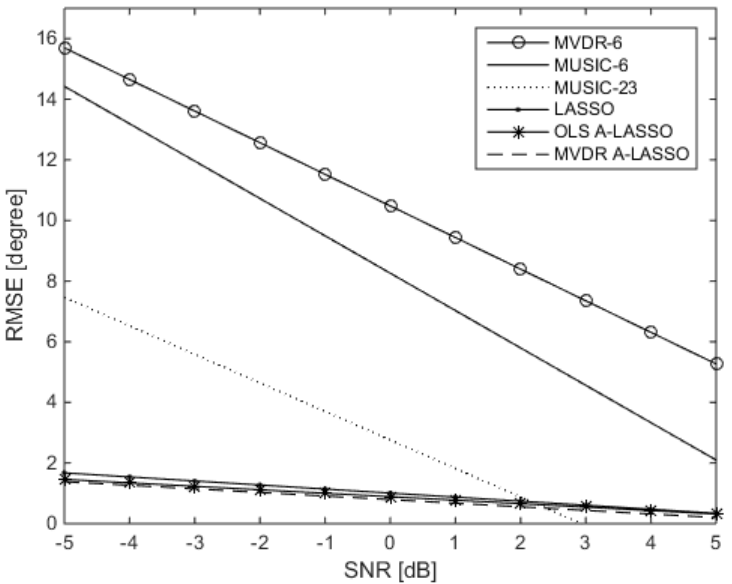
Figure 7. Performance of the LASSO algorithms as SNR is varied in comparison with that of MVDR and MUSIC algorithms, for two source signals at DOAs 60 ◦ and 120 ◦ , 10 snapshots and after one iteration of the MVDR A-LASSO and OLS A-LASSO